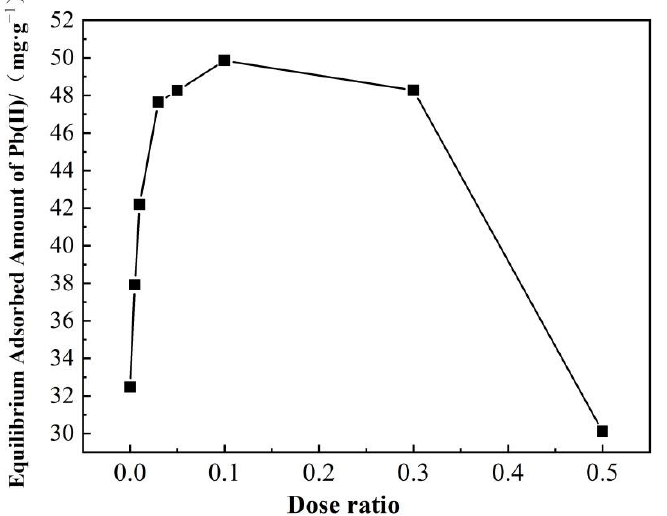
Figure 7. Effects of dose ratio of citric acid on the adsorption of Pb( Ⅱ ) onto AHCs.